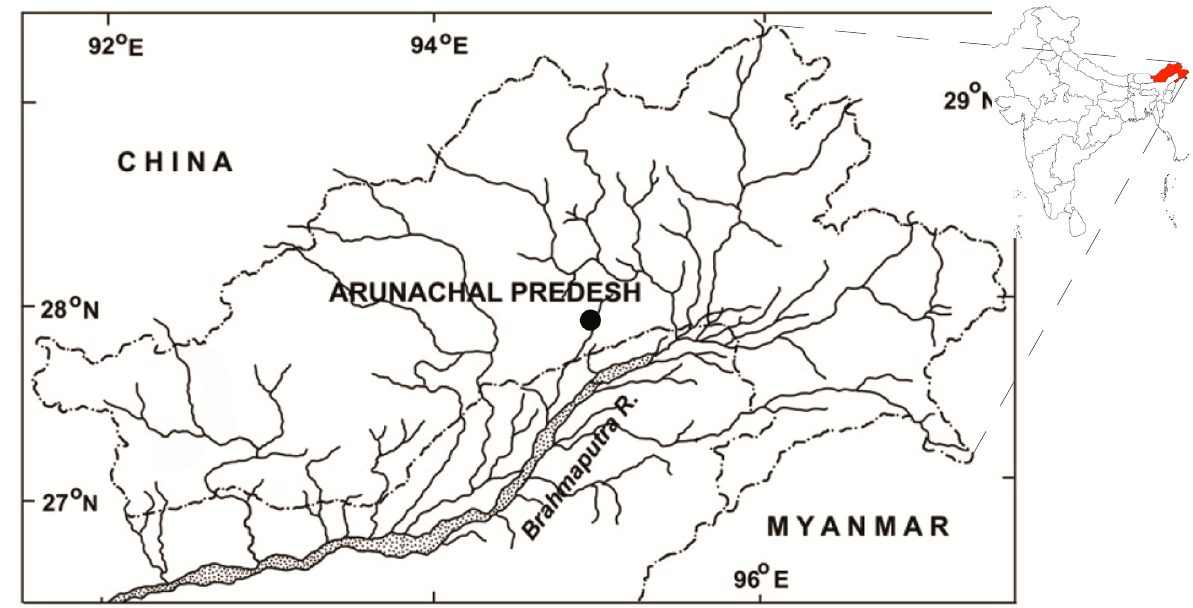
Figure 1. Map showing distribution of Badis singenensis sp. nov.